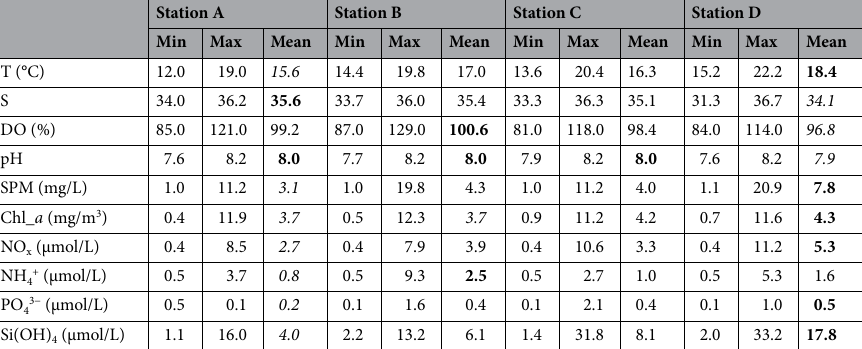
Table 1. Range of values observed for each parameter and the respective average, considering the data obtained during the six campaigns for each sampling station. In bold and italics are the highest and lowest average values for each parameter,